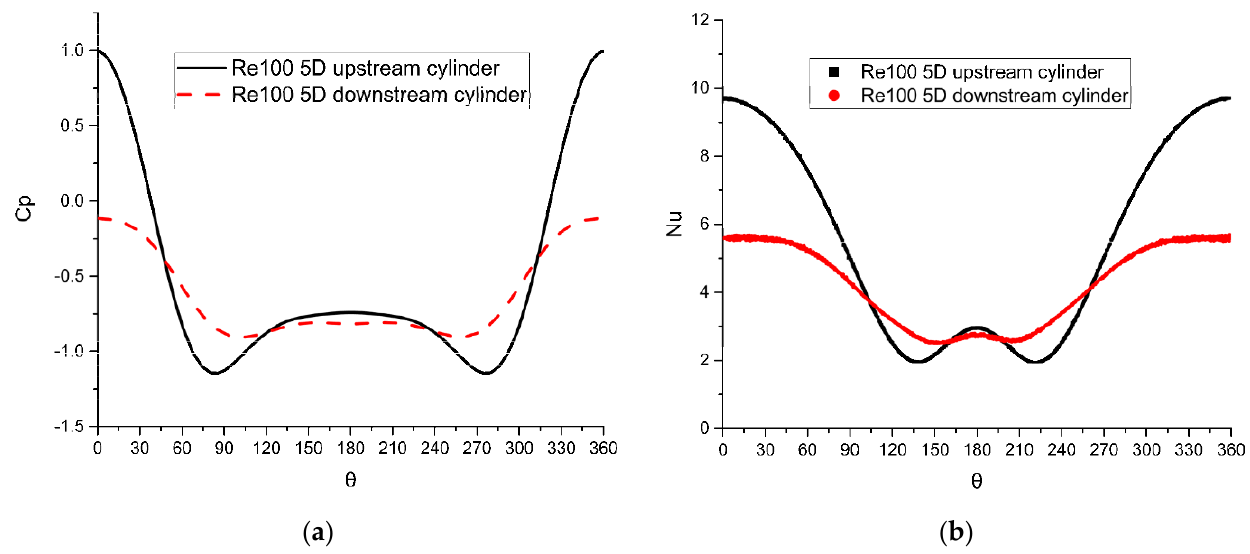
Figure 7. Re = 100, L/D = 5, time mean pressure and Nusselt number distribution around the cylinders by taking the average of five periods of the cycle: ( a ) surface pressure coefficient; ( b ) Nusselt number.